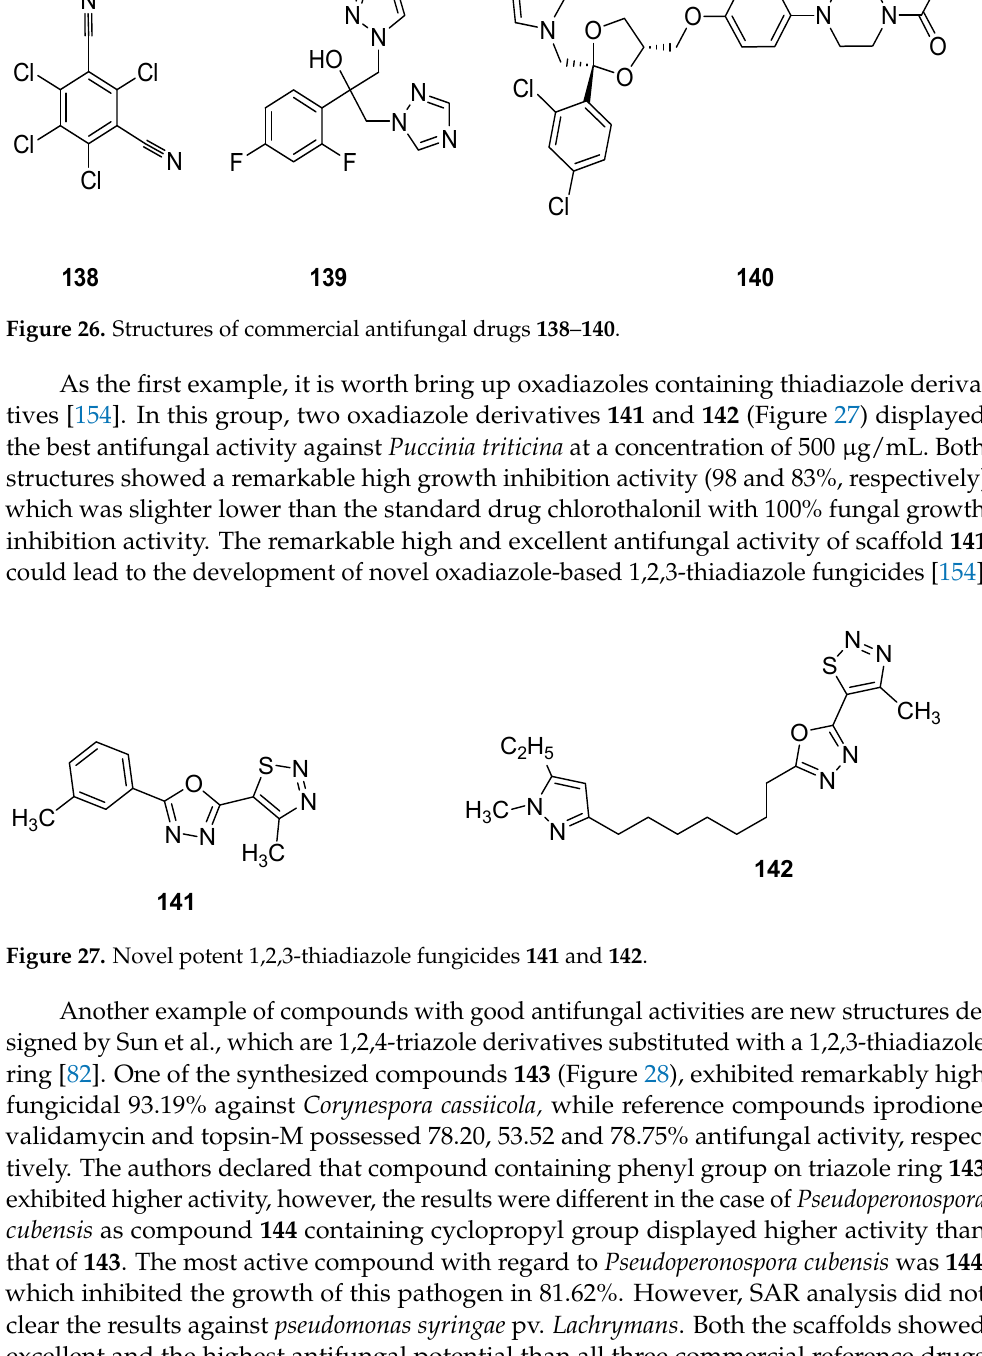
135 Figure 24. Structures of commercially available plant activators 133–135 . Du et al. reported a synthetic pathway for the preparation of carboxylate derivatives of thiadiazoles as potential plant activators against seven plant diseases [90]. The 1,2,3-thiadiazole derivatives 136 and 137 (Figure 25) proved to be good plant activators and displayed excellent inhibition activities against diseases such as M. melonis, (90% for 136 and 69% for 137 ), C. cassiicola (77% for 136 and 52% for 137 ), P. syringae pv. Lachrymans (42% for 136 and 42% for 137 ) and P. infestans (81% for 136 and 67% for 137 ) when results were compared with commercial BTH plant activator. The structural motifs 136 and 137 displayed significantly better therapeutic efficacy than BHT commercial drug, but the scaffold 136 had better plant activating potency than scaffold 137 [88].